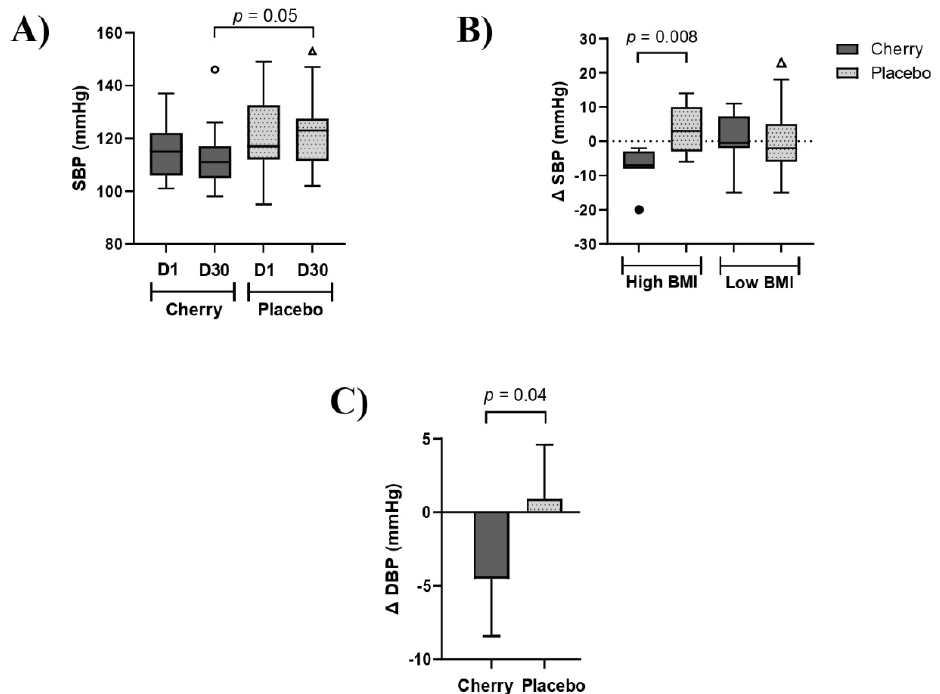
Figure 3. DSC supplementation decreased blood pressure in obese adults. ( A ) SBP levels in cherry and placebo groups. ( B ) ∆ SBP (mmHg) stratified by BMI levels. Box plots show lower quartile, median, upper quartile, and Tukey whiskers. Data not included in the whiskers are plotted as outliers. Difference between treatments was assessed by Mann-Whitney test ( C ) ∆ DBP (mmHg) levels in cherry and placebo groups. Data from DBP are estimated marginal means of ∆ values (D30-D1) obtained after adjustment for significant D1 values. Difference between treatments was assessed by unpaired t-test. High BMI: 35–40. Low BMI: 30–34.